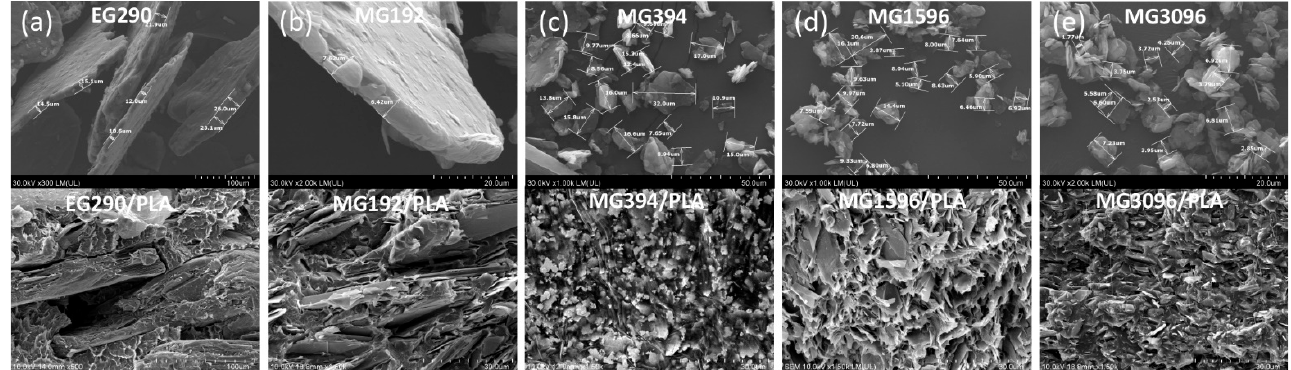
Figure 1. SEM images of neat graphite fillers (top) and graphite/PLA composites after mixing at 190 °C (bottom): ( a ) EG290/PLA, ( b ) MG192/PLA, ( c ) MG394/PLA, ( d ) MG1596/PLA and ( e ) MG3096/PLA.